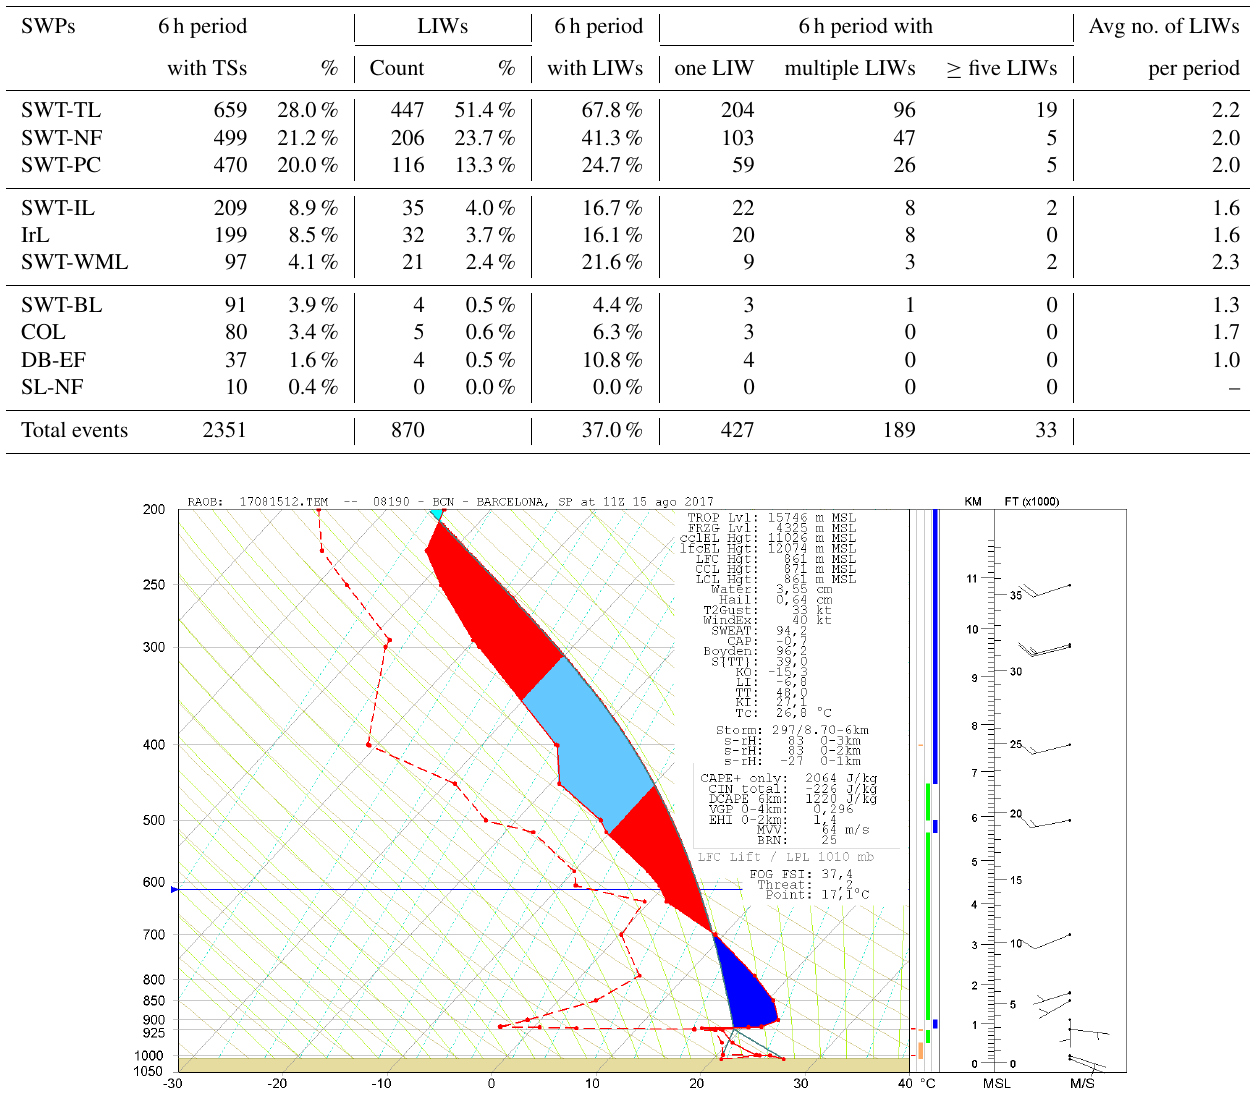
Figure 3. The 15 August 2017 12:00UTC sounding from the Barcelona sounding station. This episode, corresponding to the SWT-TL category, produced six LIWs between 12:30 and 17:30UTC. CAPE: 1837Jkm − 1 . CCL: